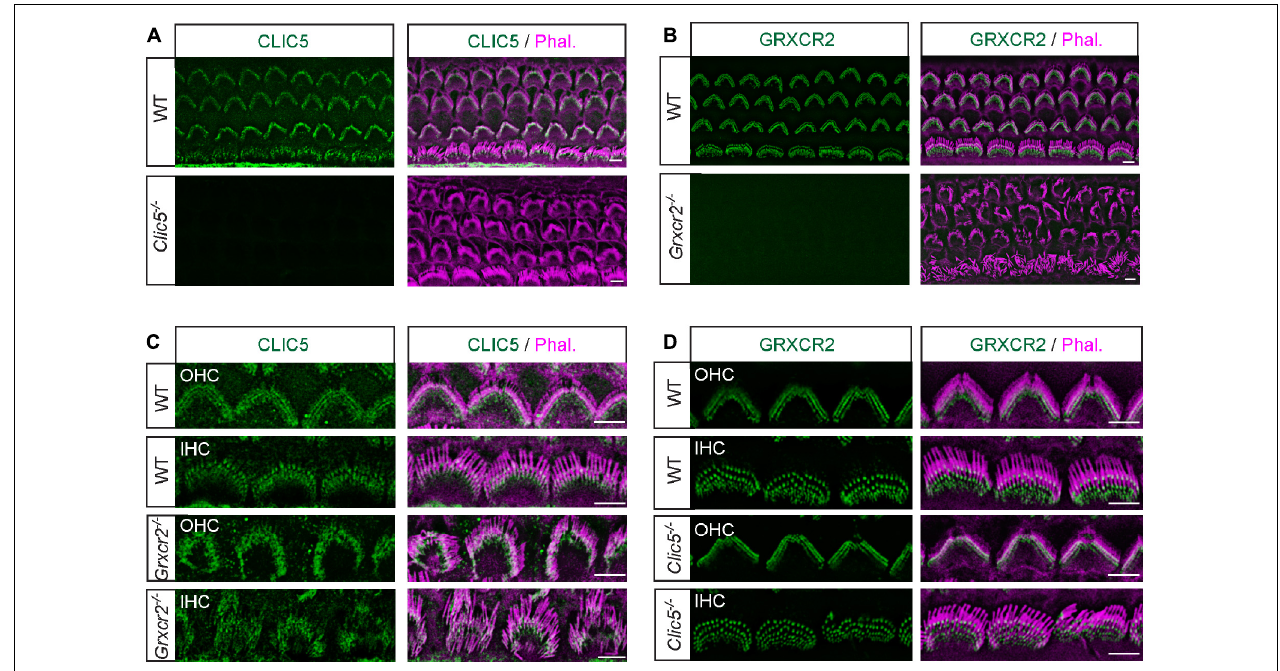
FIGURE 2 | Independent localization of CLIC5 and GRXCR2 in hair cells during development. (A) Costaining of cochlear whole mounts from wild-type and Clic5 − / − mice at postnatal day 4 (P4) with CLIC5-antibody (green) and phalloidin (red) to reveal stereocilia. Note, no immunostaining signal in Clic5 − / − hair cells, suggesting that the CLIC5-antibody is specific. (B) Costaining of cochlear whole mounts from wild-type and Grxcr2 − / − mice with GRXCR2-antibody and phalloidin. Note, no immunostaining signal in Grxcr2 − / − hair cells, suggesting that the GRXCR2-antibody is specific. (C) Co-staining of P4 cochlear whole mounts from wild-type and Grxcr2 − / − mice with CLIC5-antibody and phalloidin. Note, CLIC5 was concentrated at the base of stereocilia in outer hair cells (OHCs) and inner hair cell (IHCs) of wild-type and Grxcr2 − / − mice. (D) Co-staining of P5 cochlear whole mounts from wild-type and Clic5 − / − mice with GRXCR2-antibody and phalloidin. Note, GRXCR2 was concentrated at the base of stereocilia in wild-type and Clic5 − / − hair cells. Scale bars: 5 µ m.